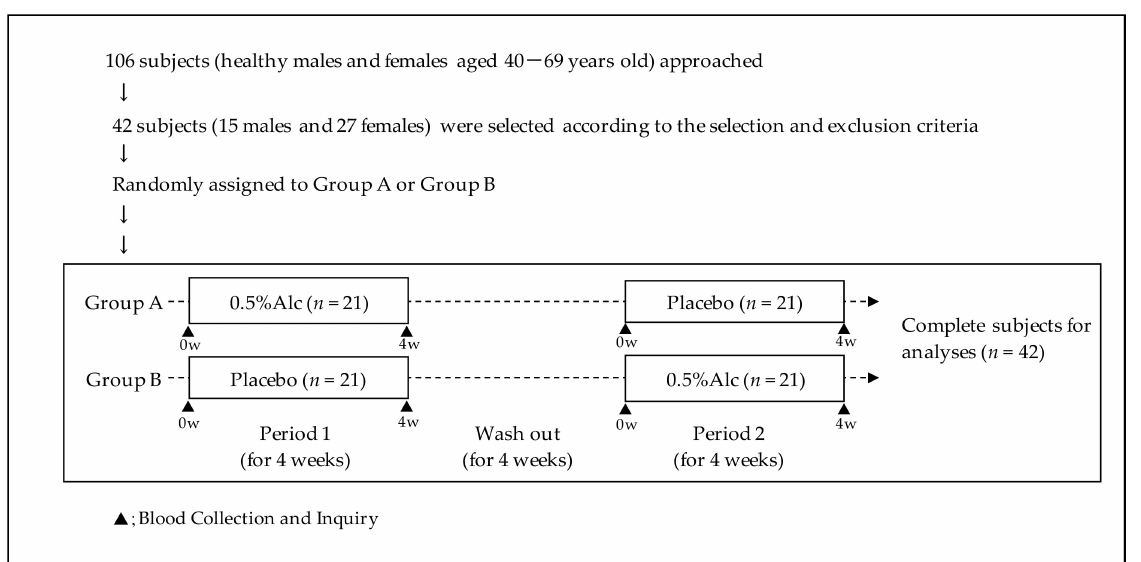
Figure 1. Schedule of the randomized, double-blind, placebo-controlled crossover clinical study. The study was performed over a 12-week